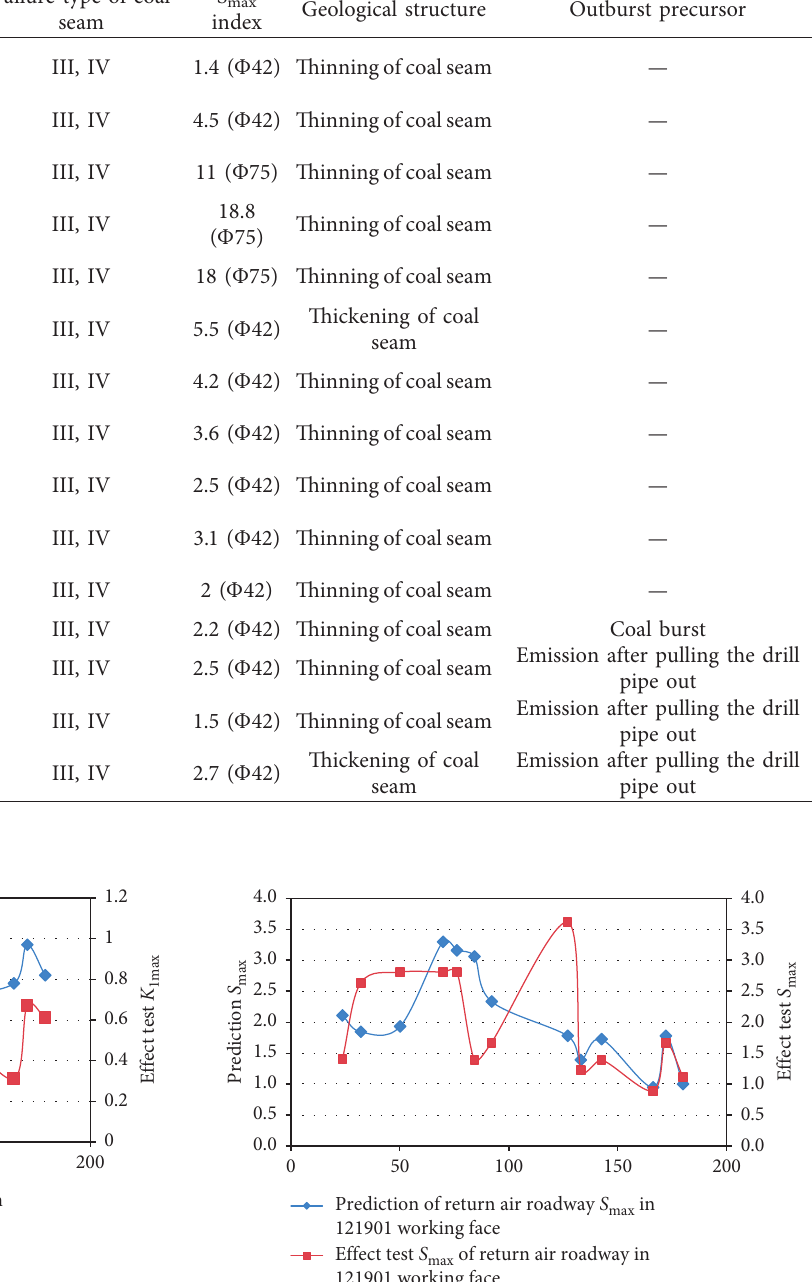
max before and after taking